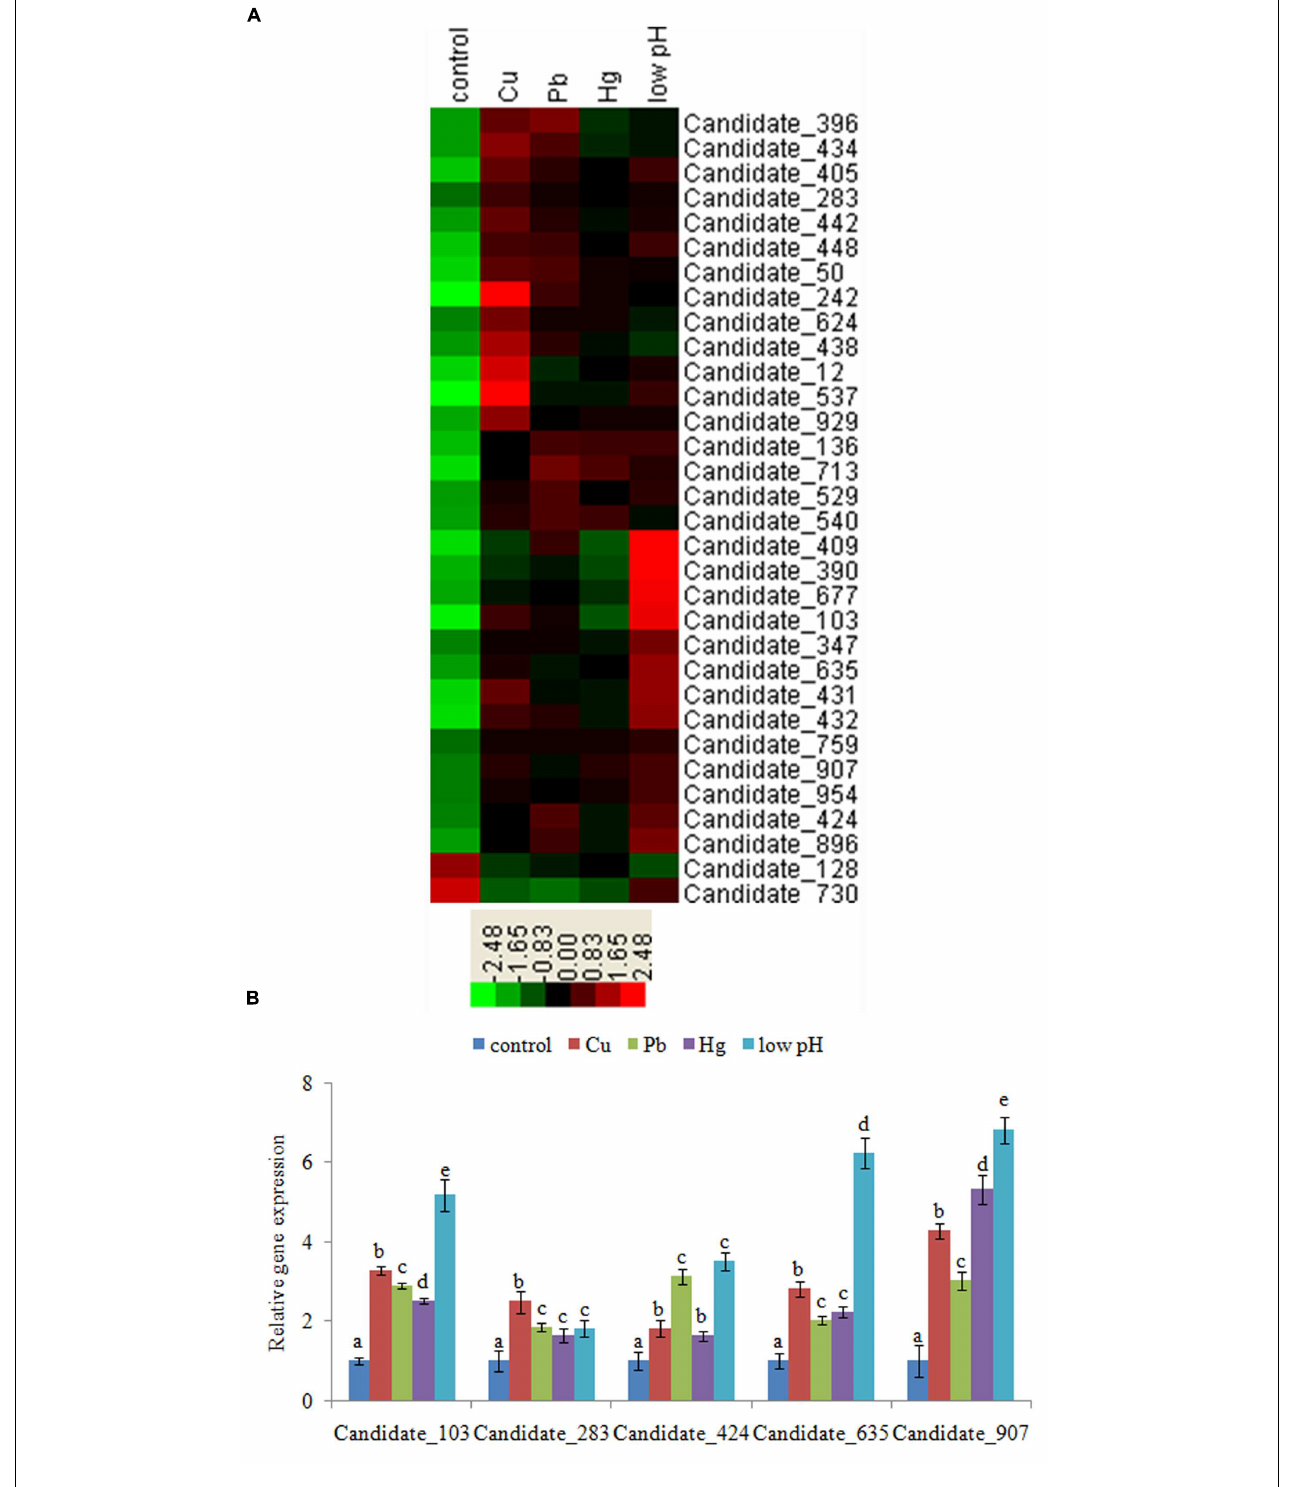
FIGURE 1 | (A) Hierarchical clustering of commonly changed ncRNAs. Green and red indicate decreased and increased expression, respectively. Transcripts were clustered by hierarchical clustering using the complete linkage algorithm and Pearson correlation metric in R. (B) Validation of the results of high-throughput sequencing. QPCR analysis of the expression of 5 novel ncRNAs chosen from the 32 commonly changed ncRNAs was performed. The means of treatments not sharing a common letter are significantly different at P < 0.05 (Dunnett’s).